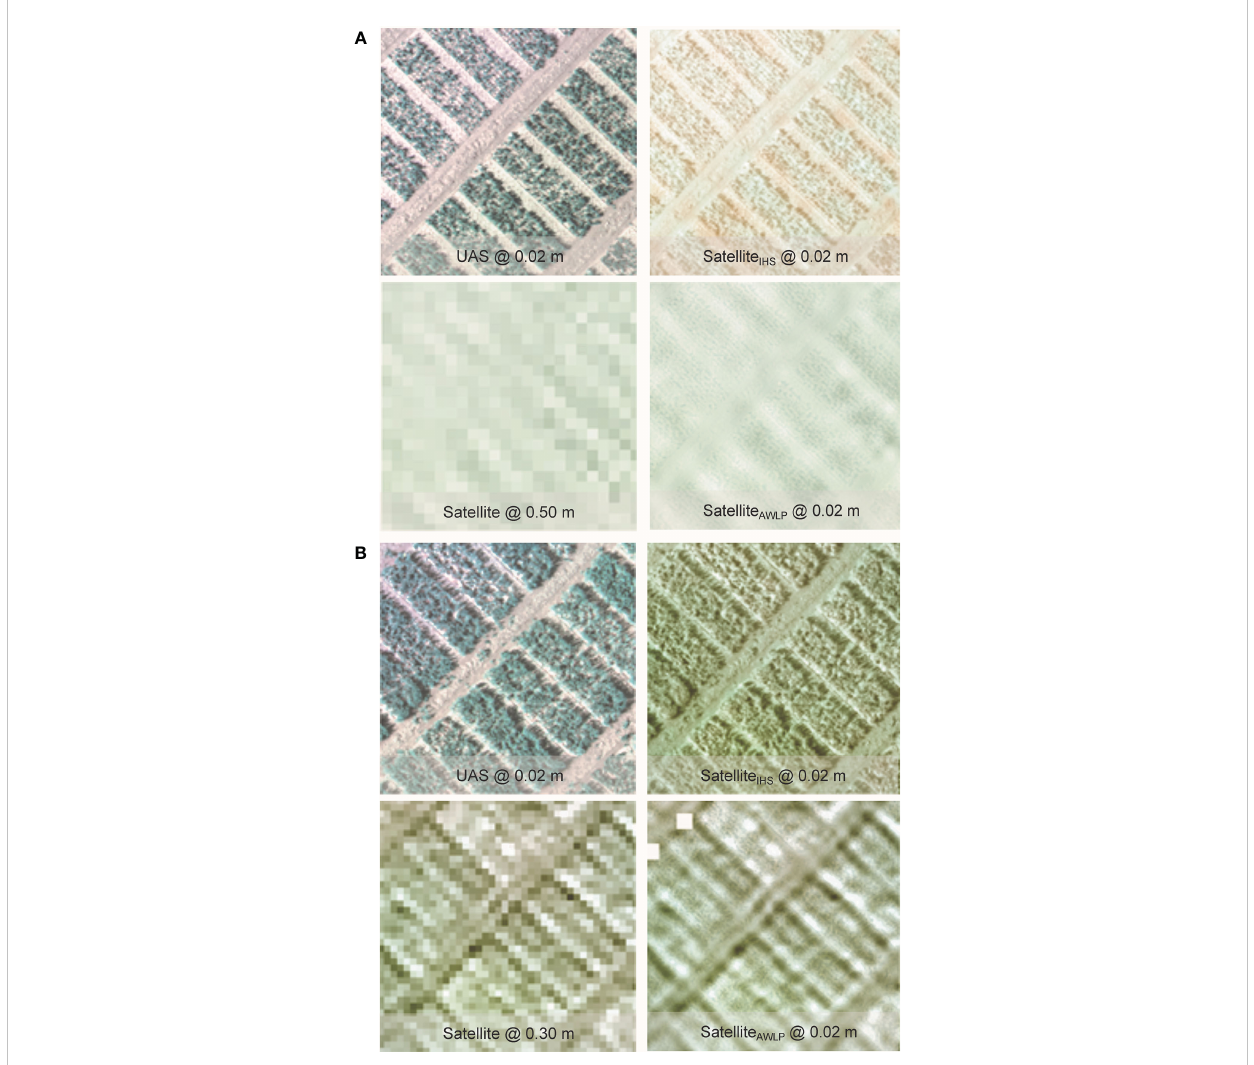
FIGURE 6 Visual comparison of RGB from the original satellite and UAS imagery, and pan-sharpened satellite imagery generated using IHS and AWLP approaches from Site 1 at TP 1 (A) and TP 2 (B)